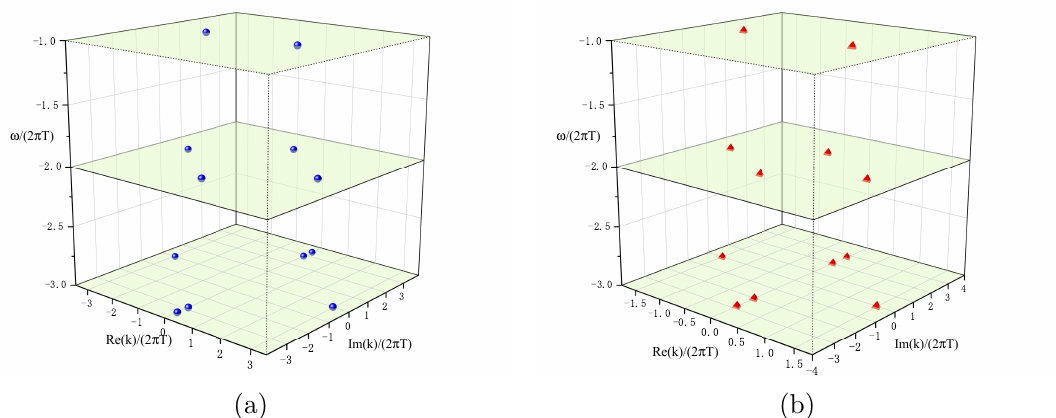
Figure 4 . The first three order pole-skipping points of Maxwell vector mode A y in the anisotropic system near Lifshitz points. (a) θ = 9 , ζ = − 1 , z = φ = 1 ; (b) θ = 4 , ζ = − 1 , z = φ = − 1 .